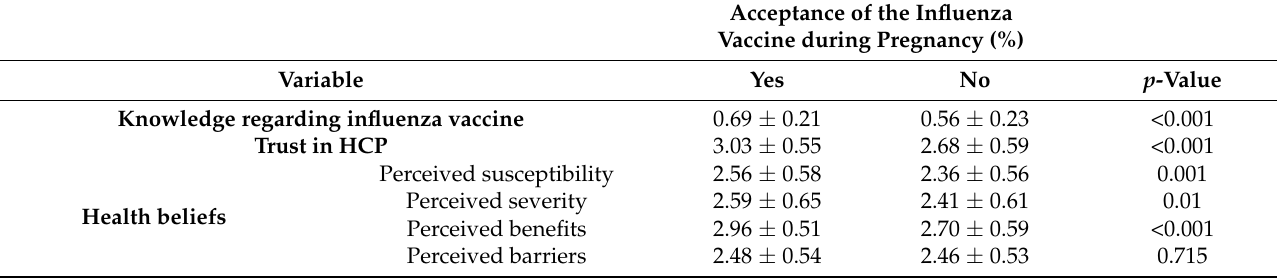
Table 3. Acceptance of the influenza vaccine by knowledge, trust in healthcare providers, and health